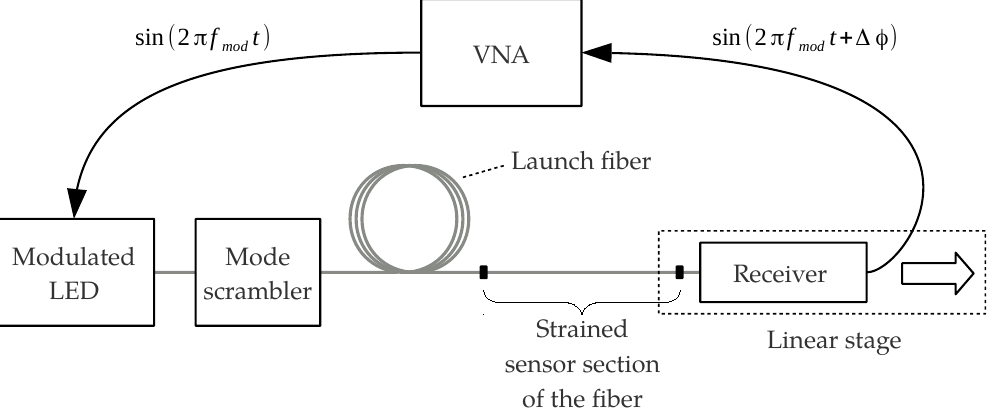
Figure 5. Setup for the strain measurements. VNA: vector network